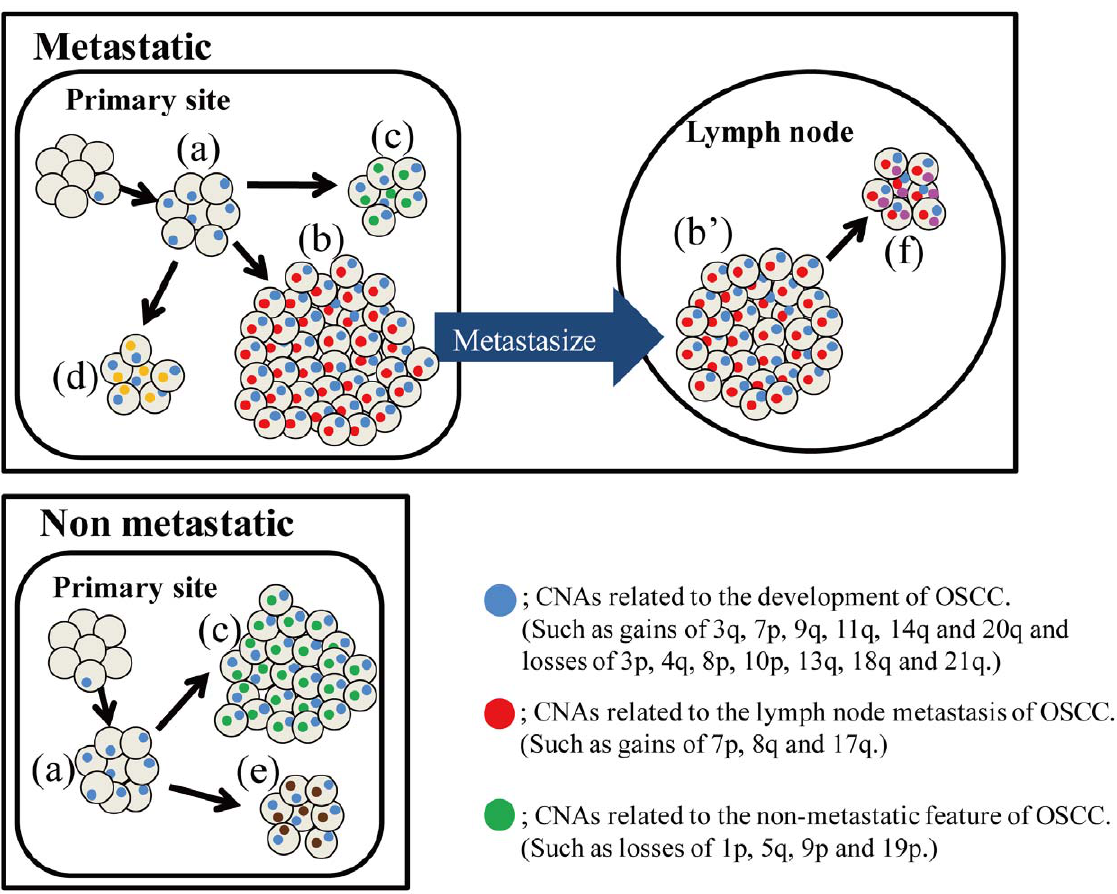
Figure 7. Hypothetical model for the development of metastatic OSCC. Clear gray circles indicate cells. Small colored circles indicate genomic aberrations. OSCC arises from a single cell with one (or a few) genomic aberrations. The single clone then proliferates more effectively than its neighbors (a). During the process of proliferation, some tumor cells acquire additional mutations at random. Subsequently, each of the genetically distinct subclones forms a unique subpopulation in the primary tumor (b, c, d and e). Among these subpopulations, only those with the capacity for metastasis can spread to cervical lymph nodes (b and b’). After metastasis, one (or a few) subpopulation may again develop further genetically distinct subpopulations through clonal evolution (f). In the advanced stage of progression, the primary tumor and metastases become predominantly populated by single clones with the capacity for metastasis (b and b’).